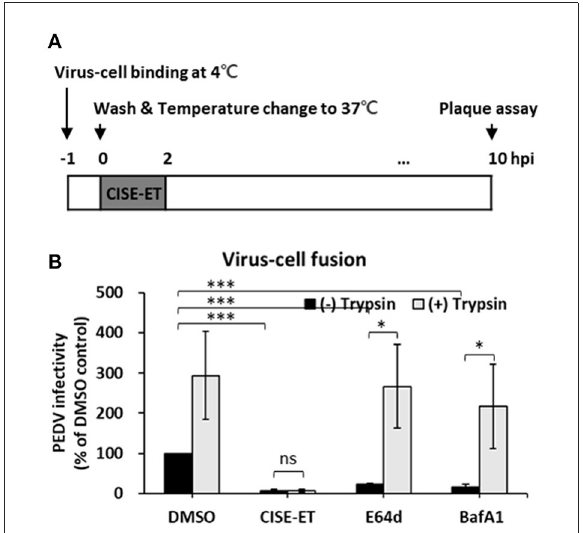
FIGURE5 CISE-ET inhibited virus–cell fusion and proteolytic cleavage of S proteins. (A) Schematic of the synchronized infection experiments of virus–cell fusion. Vero cells were incubated with PEDV (MOI = 1) for 1h at 4 ◦ C for initial binding, washed with PBS and treated with 30 µ g/ml CISE-ET and/or 10 µ g/ml trypsin for 2h at 37 ◦ C. The inoculums were then removed, and the cells were maintained in SFM for 8h. At 10 hpi, the virus titers were measured by plaque assay. (B) The viral infectivity is expressed relative to that found for the DMSO control group. The error bars represent the SDs from the means ( n = 3). * P < 0.05; *** P < 0.001; ns, not significant.